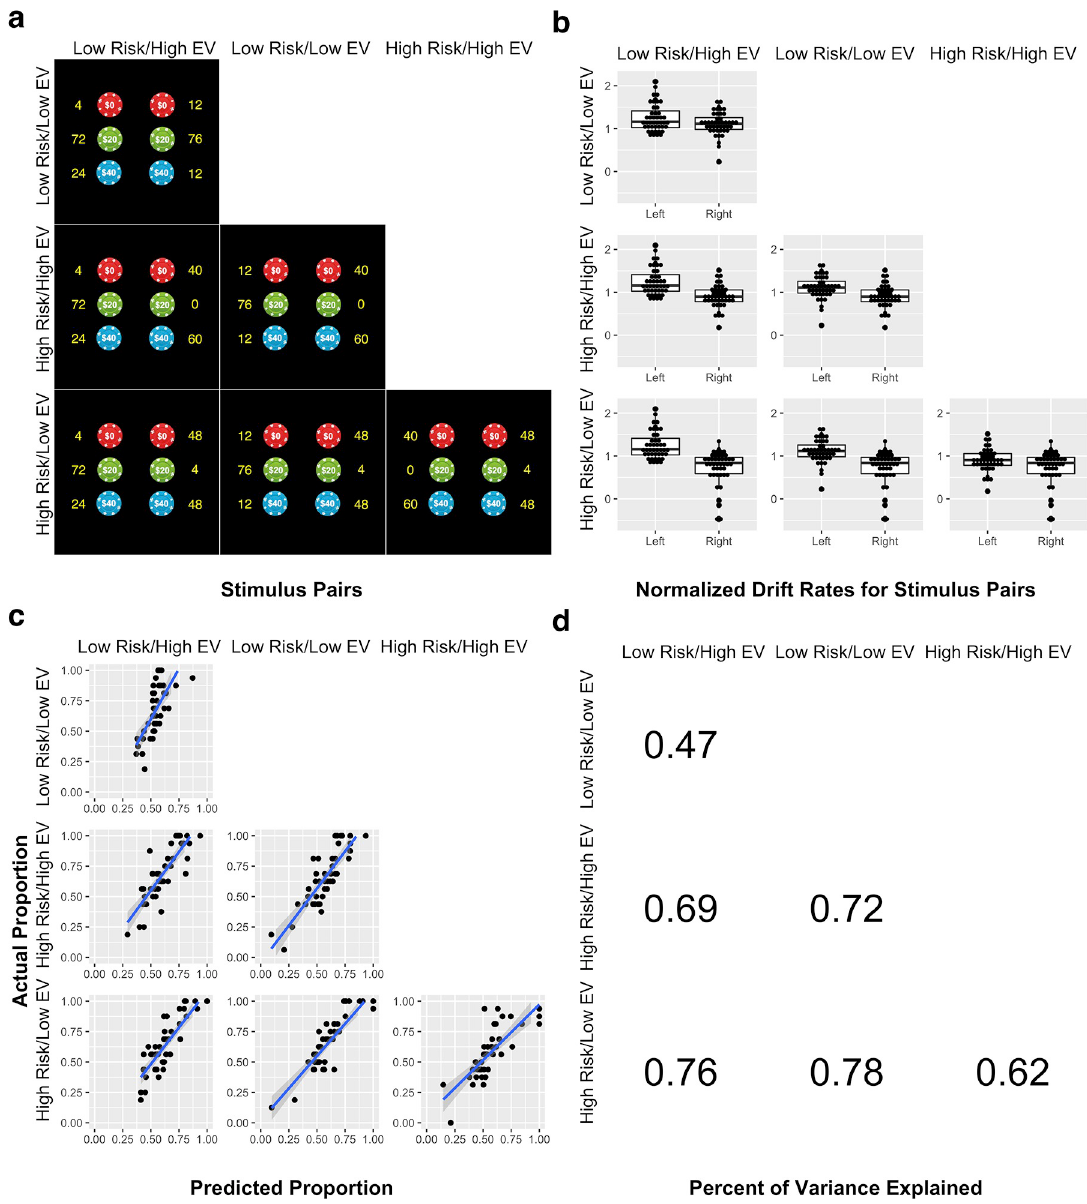
Fig 3. Linear ballistic accumulator (LBA) model of probabilistic decision-making. (a) The six stimulus pairs encountered by subjects in the decision-making experiment. Subjects were asked to choose one of two gambles, each of which represented a random drawing of a chip worth 0, 20, or 40 virtual dollars, from a pool of 100 chips. The yellow numbers represent the number of each chip that comprise the 100 total chips. The four decision stimuli are high risk/high EV, high risk/low EV, low risk/high EV, and low risk/low EV. (b) Normalized drift rate parameters from LBA model. Drift rates represent the average rate of accumulation of evidence for each stimulus; when evidence for a given stimulus reaches a decision threshold, that stimulus is selected. Lower risk and higher expected value (EV) were associated with higher drift rates. Subject-level drift rates are shown for each stimulus for each of the 6 possible stimulus pairs. (c) Predicted and actual choice rates for each stimulus pair when the LBA was fit using the entire dataset. Choices predicted based on LBA parameters were strongly correlated with actual subject choices for each of the six stimulus pairs. (d) Percent of variance in subject choices explained by model-based predictions for each possible stimulus pair.